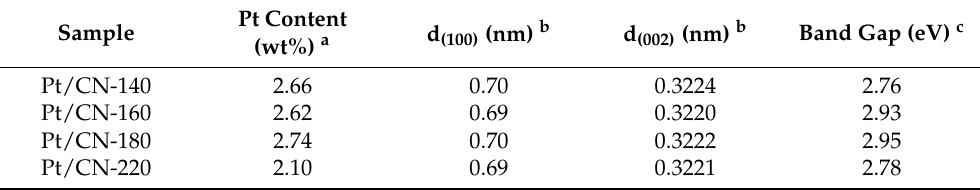
Figure 1. Schematic illustration of the synthetic procedure of ethanol solvothermal-treated CN. The TEM and SEM analyses characterized the morphological and textural properties of all samples. The FE-SEM images of the samples display the characteristic sheet-like morphological structure (Figure S1). The EDS elemental mappings in Figures 2 and S2 depict the distributions of C, N, and Pt in the four samples. Although similar amounts of Pt were loaded onto the four samples (Table 1), the purple spots assigned to Pt were more homogeneously dispersed in the Pt/CN-160 sample than were those in the Pt/CN-140, Pt/CN-180, and Pt/CN-220 (Figure 2) samples. The TEM images in Figure 3 also demonstrate that the Pt species observed in all four samples was reduced from Pt 4+ during the photodeposition process. The areas marked by red circles correspond to Pt and PtO particles or clusters anchoring on the g-C 3 N 4 surface. These particles are nearly spherical with an order of less than 2 nm in average size. Furthermore, it is evident that, although the average diameter of a Pt particle in Pt/CN-140 is the smallest at 1.38 ± 0.33 nm, some large Pt clusters are still found, implying an agglomeration of Pt species during the photodeposition process. Pt/CN-160, by contrast, possesses a more uniform Pt dispersion at an average particle size of 1.43 ± 0.39 nm. In the inset of Figure 3b, the high-resolution TEM image of the Pt/CN-160 reveals the lattice fringes of 0.23 and 0.27 nm that can be attributed to the (111) plane of Pt and the (002) face of PtO, respectively [23,24]. This can be connected with further support from the Pt 4f XPS results in which PtO is one of the main Pt species after the photodeposition process. Table 1. Physicochemical and band gap values of the Pt/CN